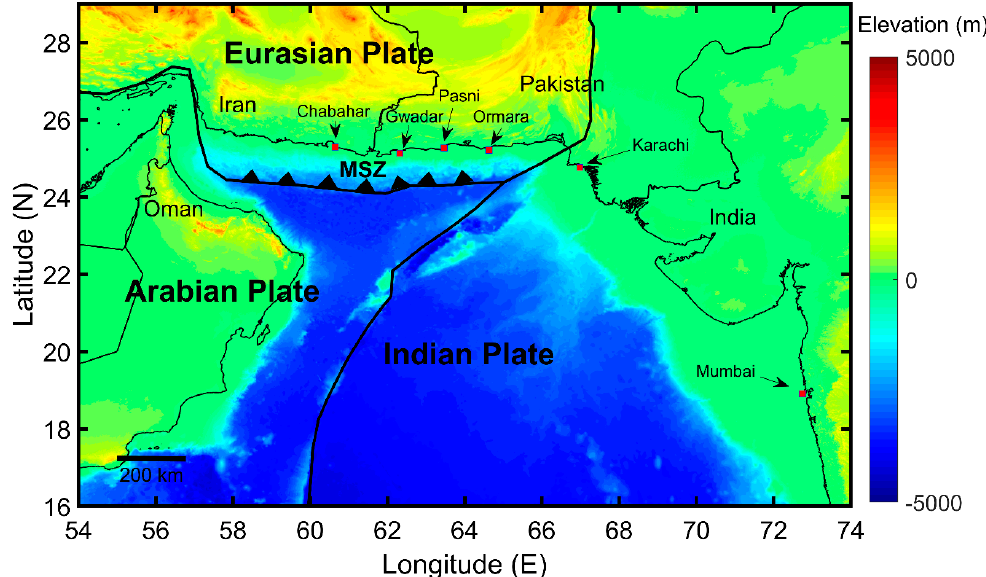
Figure 1. The Makran Subduction Zone in the northwestern Indian Ocean showing major coastal cities and tectonic setting.